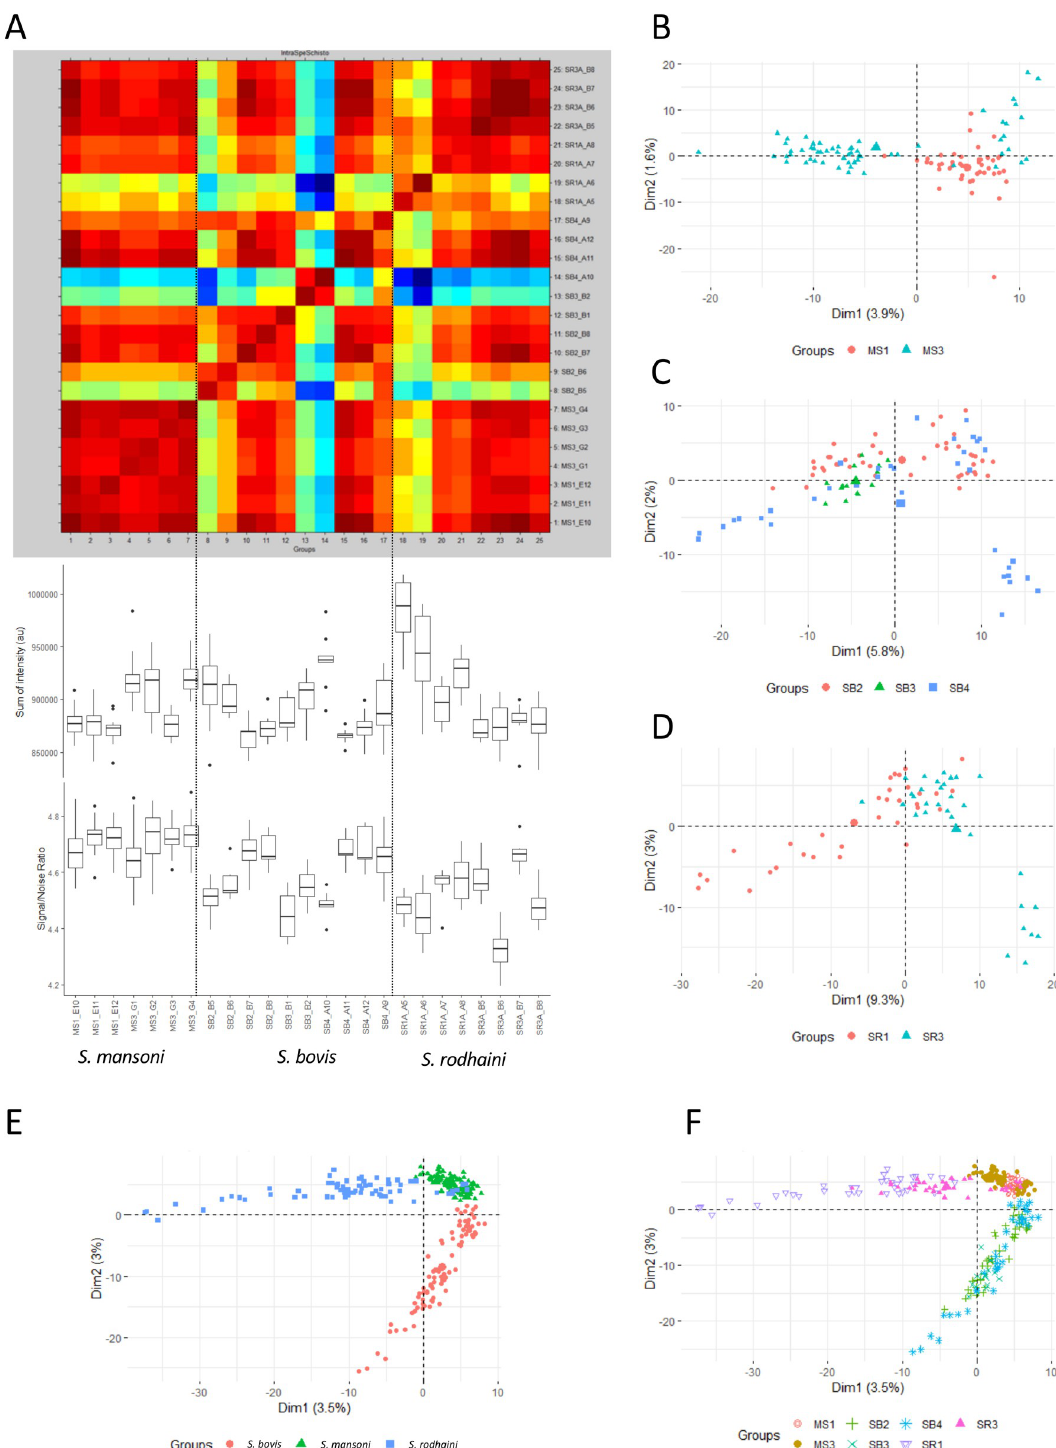
Fig 3. Intraspecies spectra reproducibility. Panel A. CCI matrix obtained with MALDI-Biotyper default parameters, sum of intensity and SNR for seven molluscs. B. First two principal components of PCA analysis of S . mansoni spectra. C. First two principal components of PCA analysis of S . bovis spectra. D First two principal components of PCA analysis of S . rodhaini spectra. E. First two principal components of PCA analysis of the whole reproducibility dataset, colours representing species. F. First two principal components of PCA analysis of the whole reproducibility dataset, colours representing species.